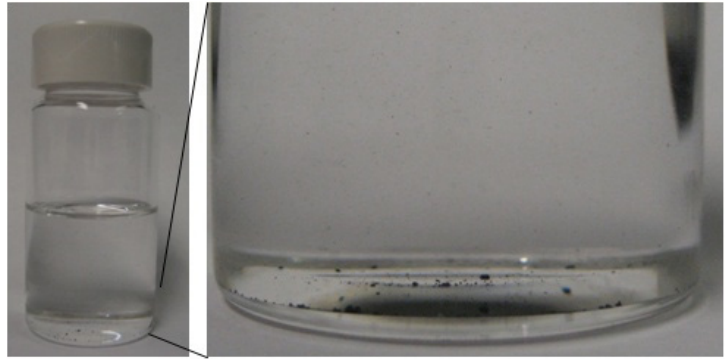
Figure 1. Images showing 3 mg of multi-walled carbon nanotubes (MWCNTs) being added into 10 mL of chloroform. In the magnified view black bundles settled on vial bottom were from as-is